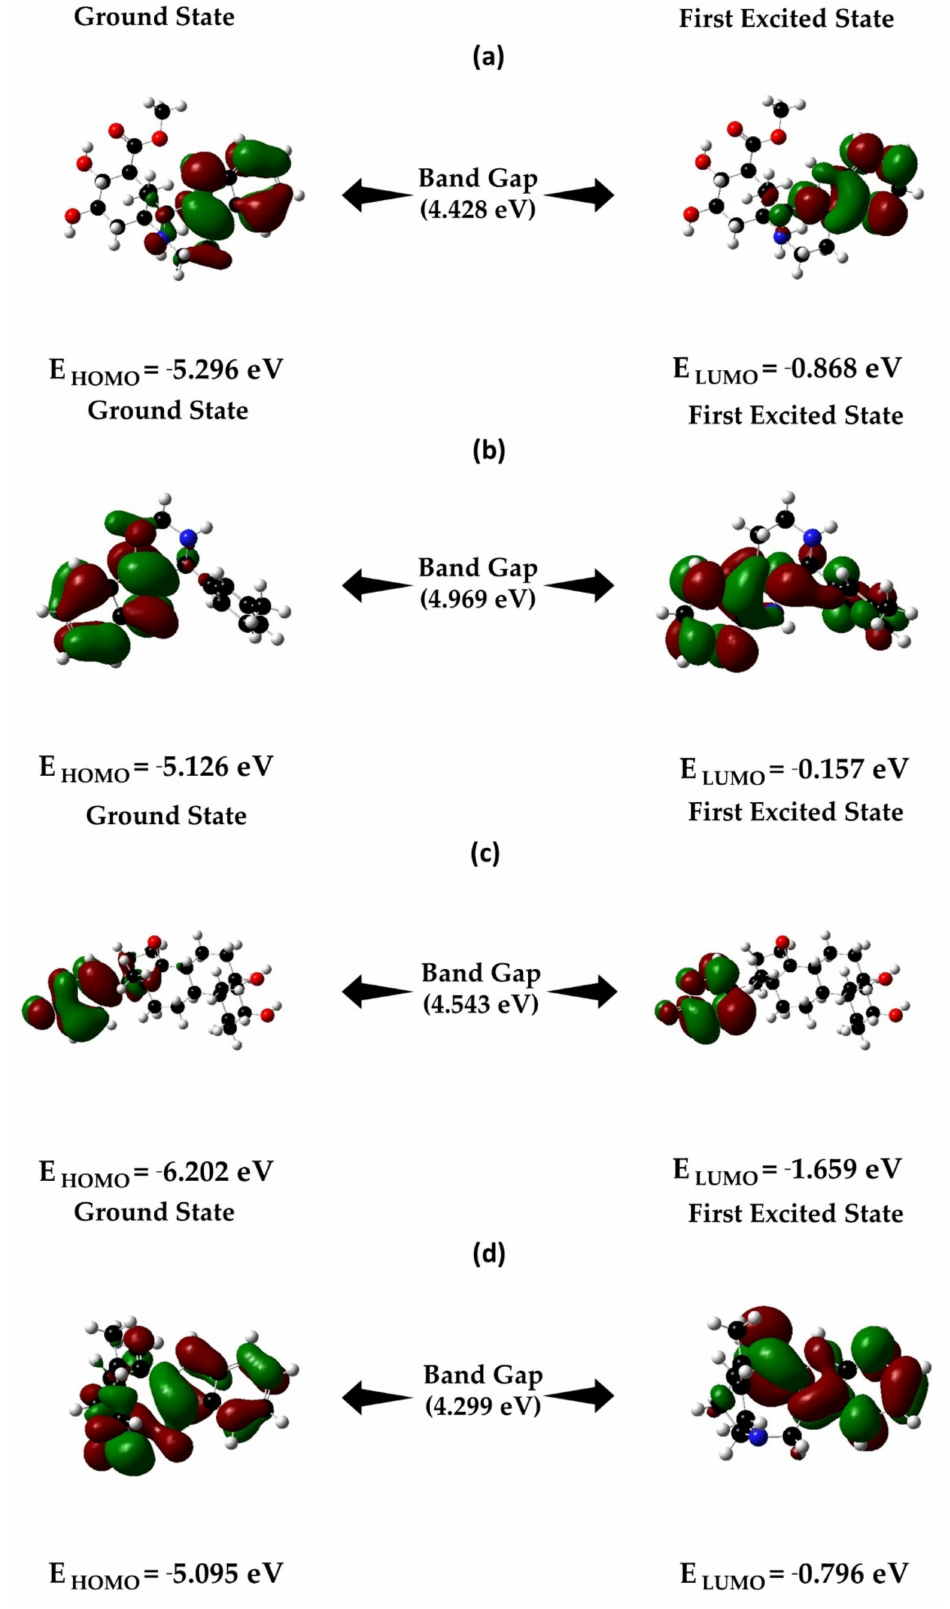
Figure 8. Energy differences and HOMO-LUMO bandgap: ( a ) CID: 102004710; ( b ) CID: 198912; ( c ) CID: 11969465; ( d ) CID: 5281349 obtained by the DFT/B3LYP/6-31G level of